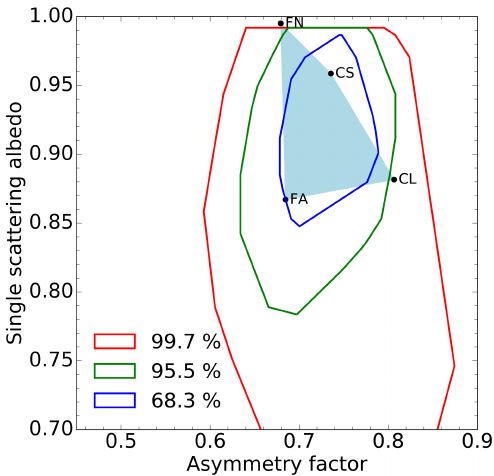
Figure 3. Example of a region (light-blue area) in the { g,ω 0 } solu- tion space at 0.44µm defined by four aerosol vertices: single fine- mode non-absorbing (FN), single fine-mode absorbing (FA), coarse mode with small radius (CS) and coarse mode with large radius (CL). The isolines show the probability that the aerosol single- scattering properties derived from AERONET observations with the method of Dubovik et al. (2006) fall within the delineated